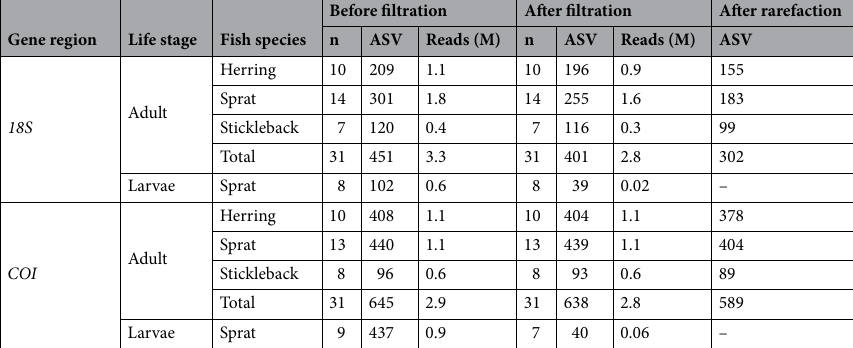
Table 1. Summary of the sample size (n), sequence reads (million) and unique amplicons variants (ASVs) for the 18S and COI barcodes associated to all adult fish and larvae species and individual adult and larvae species at each step of the downstream data processing. The first filtration was performed to remove host sequences and the rarefaction was performed for adult life stages based on the sample with lowest read count (see